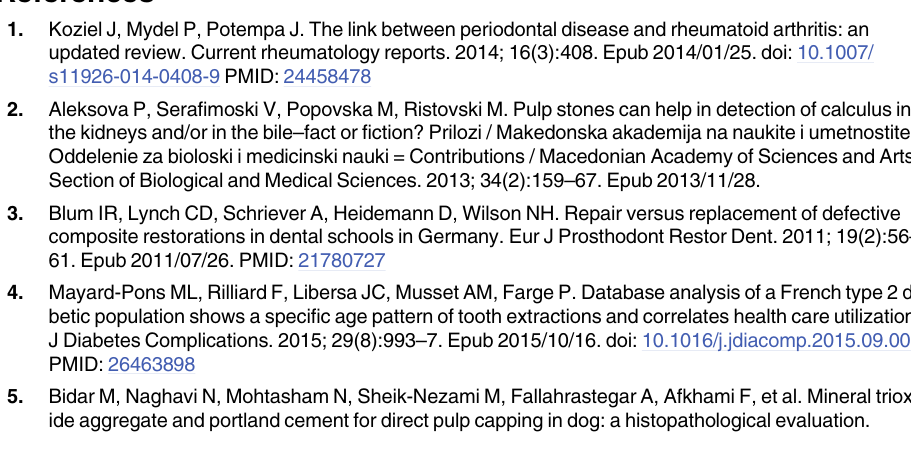
S4 Table. Detailed statistical information of the collagen type I and TGF- β 1 staining after Biodentine 1 exposure. S5 Table. Detailed statistical information of the TGF- β 1 secretion after Biodentine 1 expo-